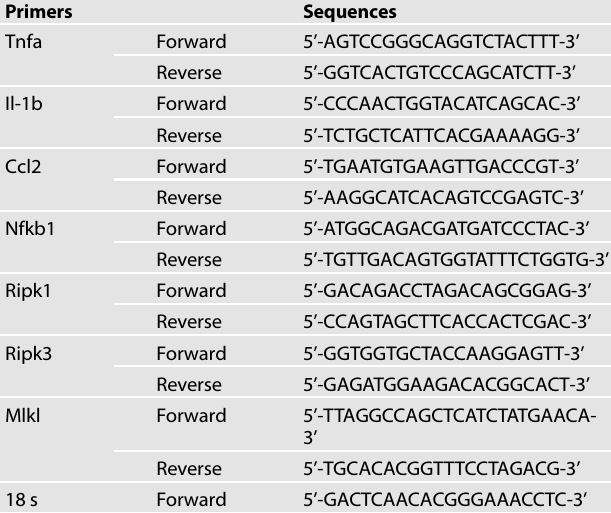
Table 3. Primer sequences for